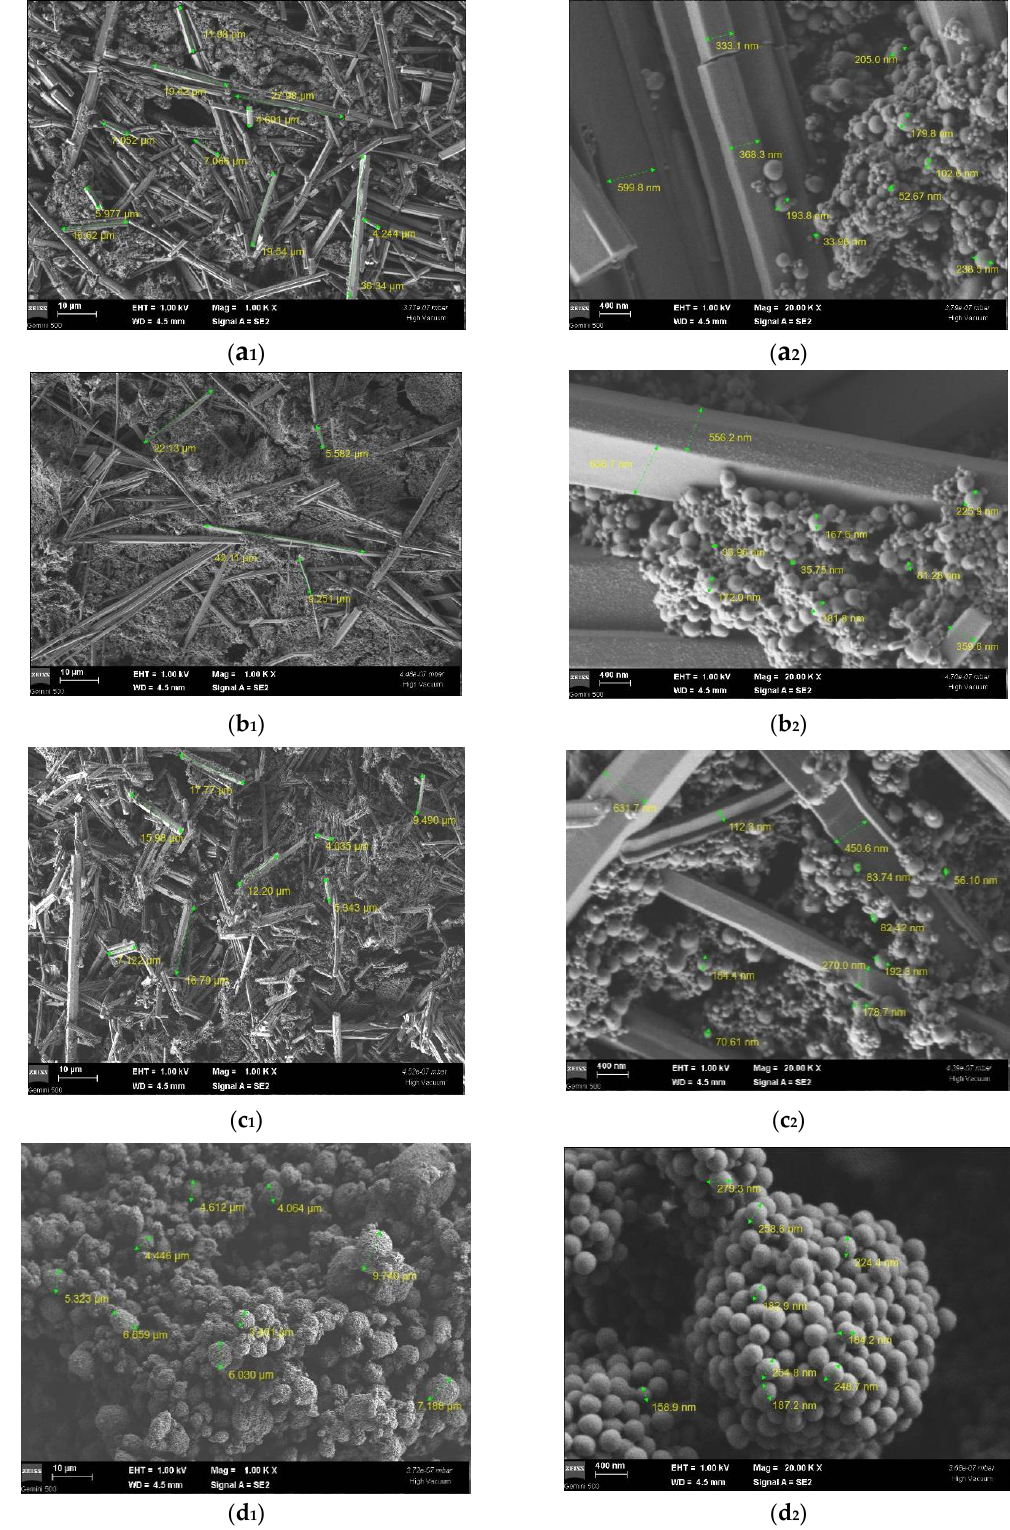
Figure 1. SEM images of the blends based on the POPD fiber like structures and the PVDF spheres corresponding to the A ( a ), B ( b ) and C ( c ) samples. Figure 1 d shows the PVDF spheres. Figure 1a 1 – d 1 show SEM images with magnification of ×1.00K, while in the case of Figure 1a 2 – d 2 , SEM images with magnification x20.00K are shown.